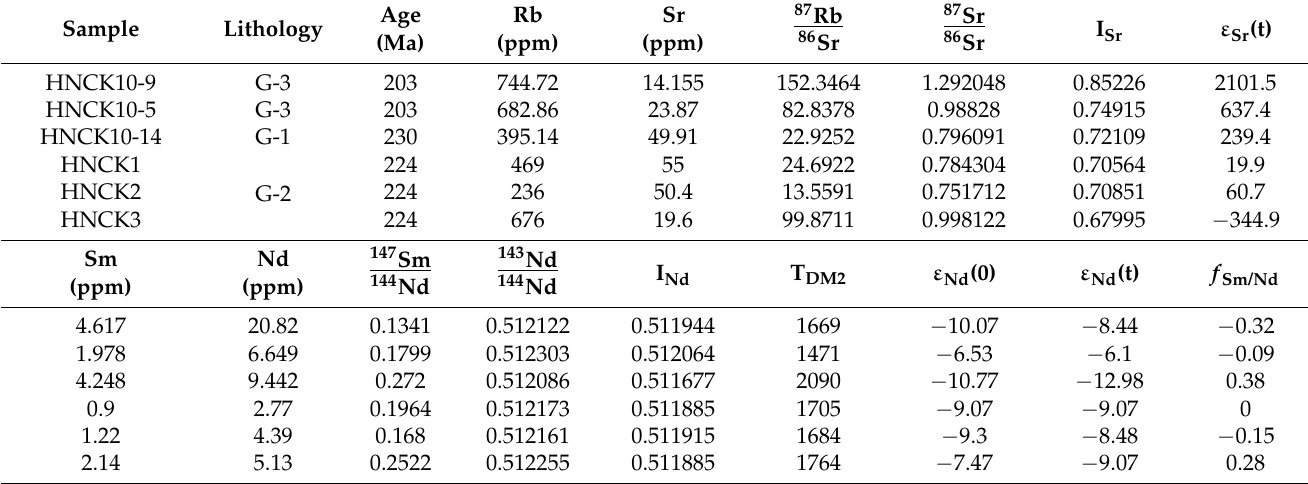
Table 5. The Sr-Nd isotopic composition of samples of granitoids from Chuankou ore